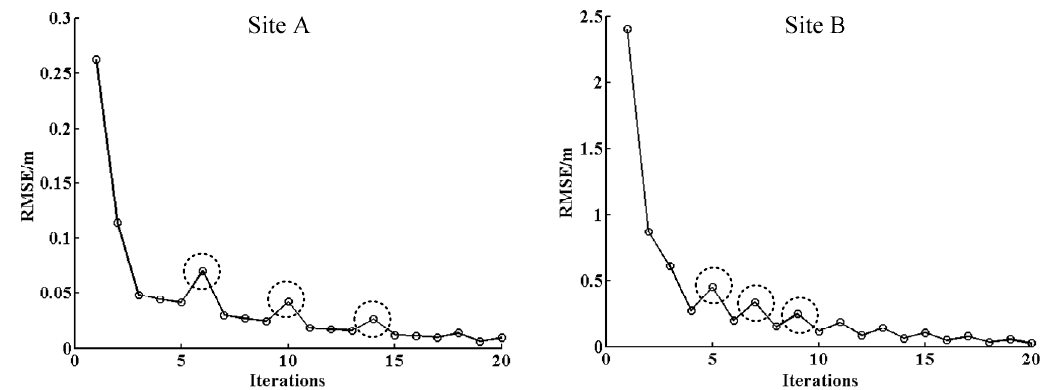
Figure 9. RMSE values of the terrain ‐ invariant regions over both sites yielded by the proposed method, with increasing iterations.